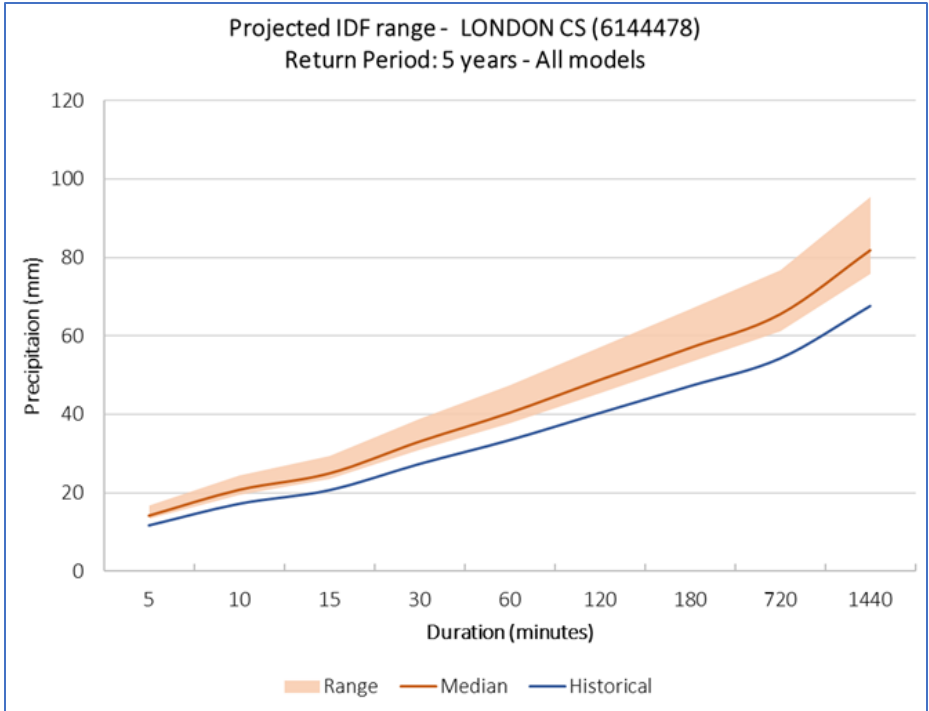
Figure 17. Projected range of the 5-year IDF curve for London station combining all models, runs and RCPs.